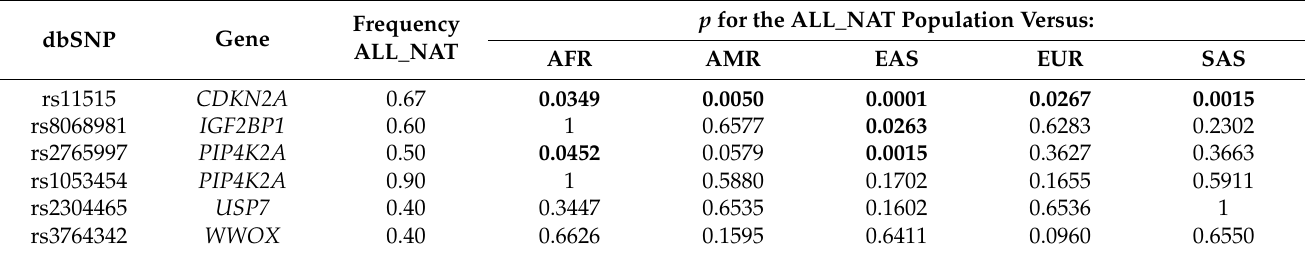
Table 4. The p values recorded for the pairwise comparisons (ALL_NAT vs. AFR, AMR, EAS, EUR or SAS) of the allele frequencies of the six key variants identified in the present study (see Table